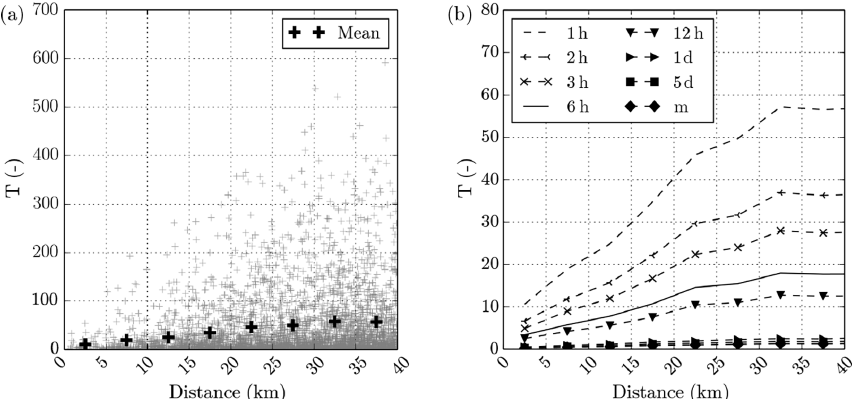
Figure 3. The T statistic over distance: (a) the results for the hourly distribution functions of all gauge pairs (the gray crosses) and their mean calculated for 5km classes. (b) The mean values of the T statistic for different temporal resolutions (for more detail on the temporal resolutions of 1d, 5d and m, see Fig.